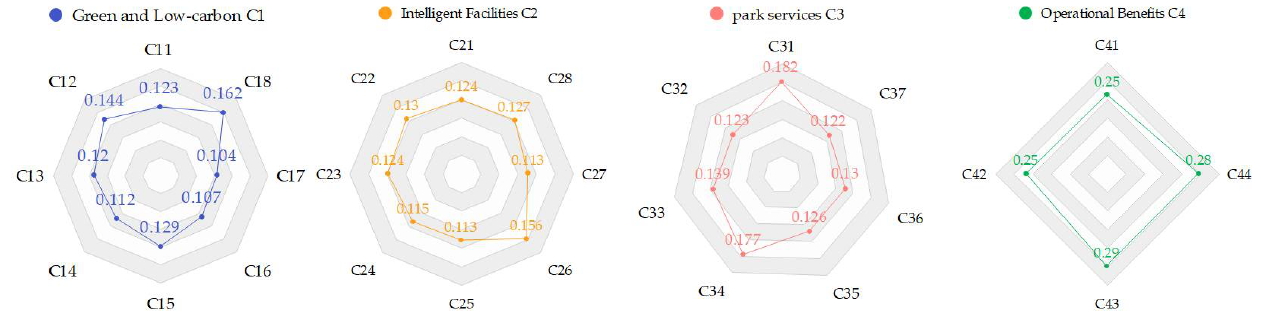
Figure 5. The four dimensions of the intelligence level of the SIPs.